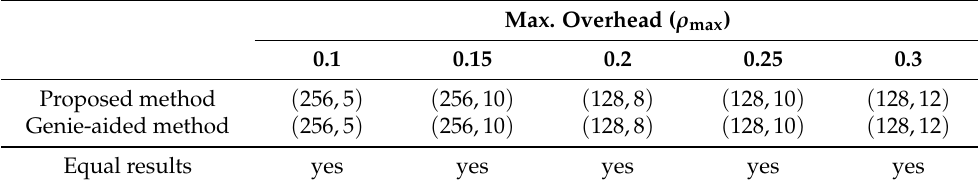
Table 5. Parameters chosen by each method for BCH1 channel.